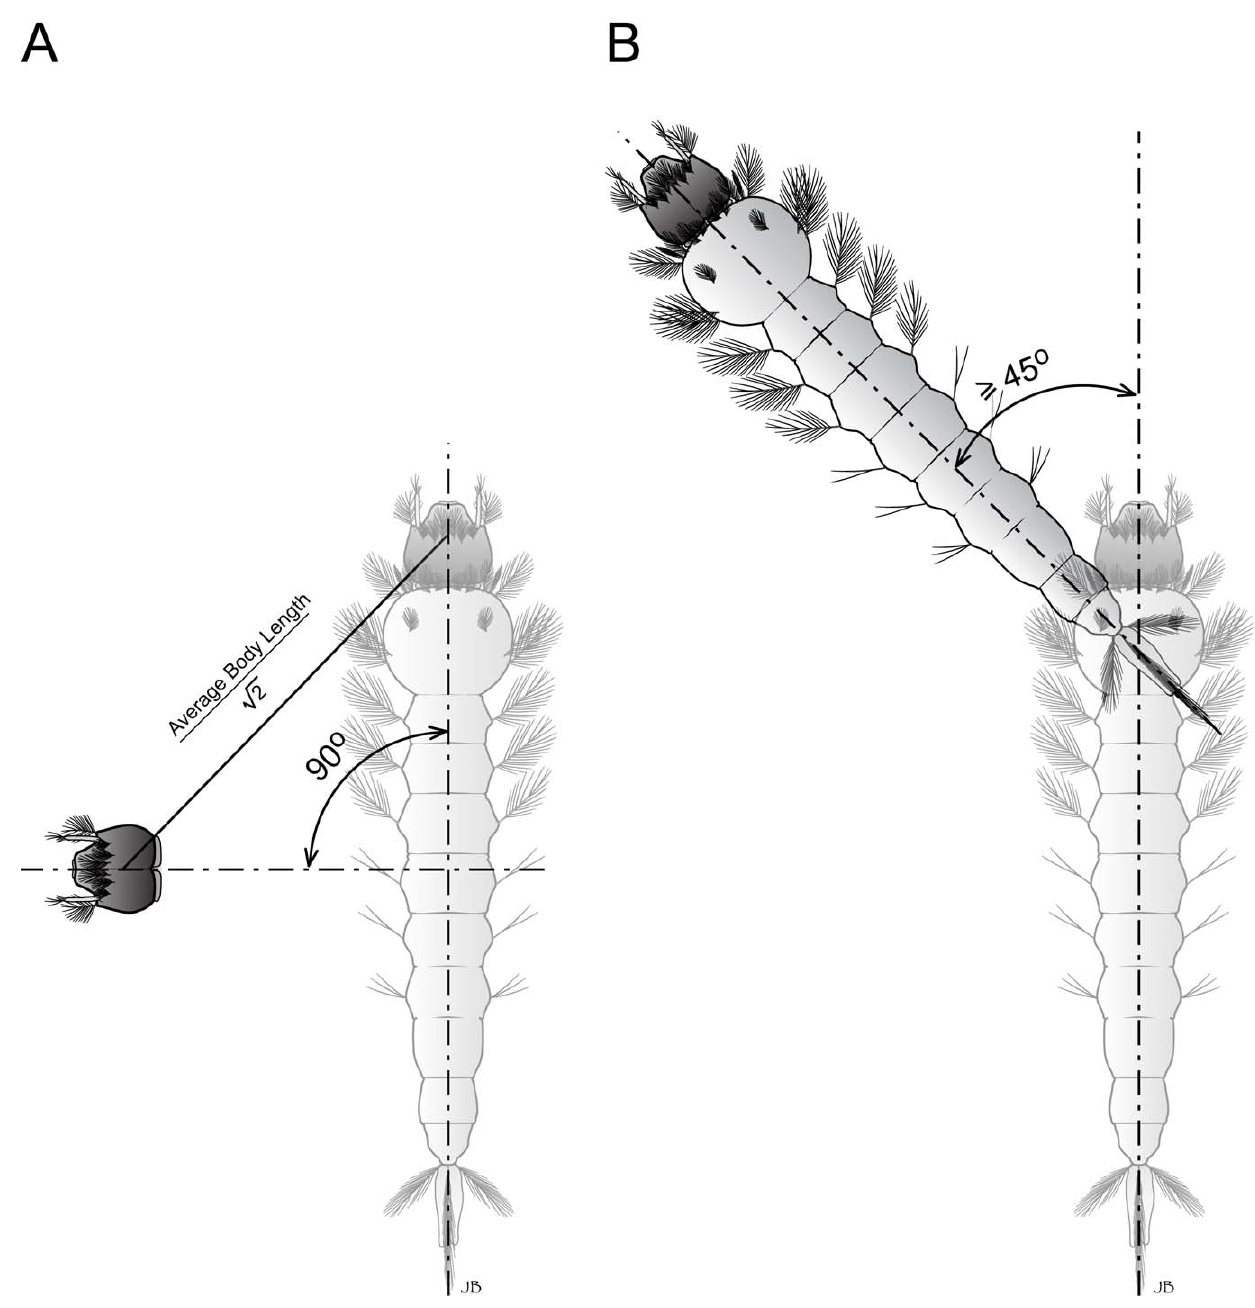
Figure 1. Operational definitions of larval movements and turns. (A) A larval body movement threshold is characterized by a larva turning its body axis by 90 u and its head traveling the distance indicated. (B) A larval turn threshold is defined by a 45 u angle between two successive larval tracking vectors.